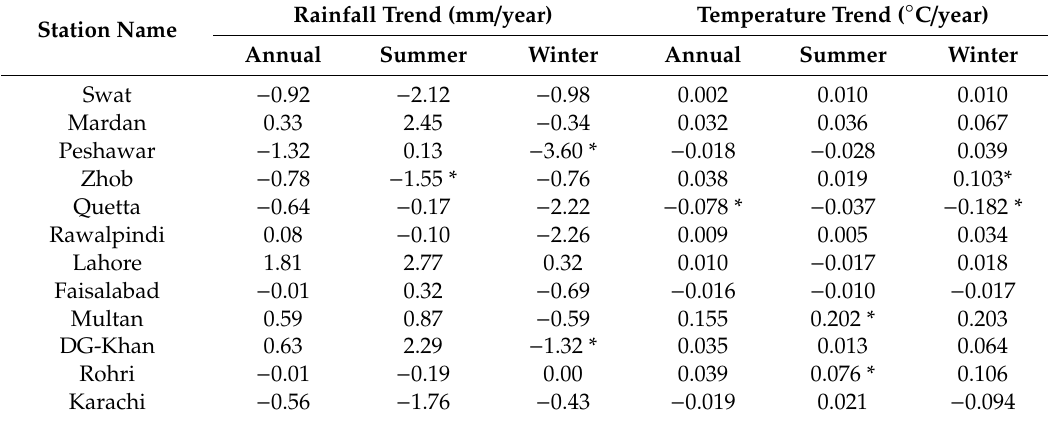
Table 4. Rainfall trends (mm / year) and temperature trends ( ◦ C / year) for selected stations during 2003–2017; * represents statistically significant trends over selected